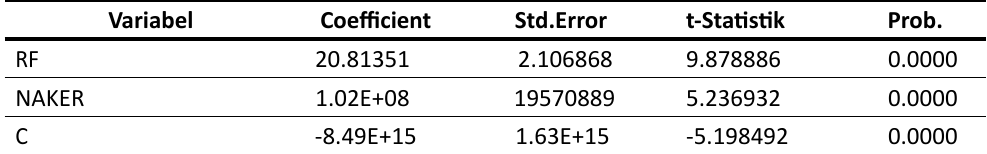
Table 1 : OLS Regression